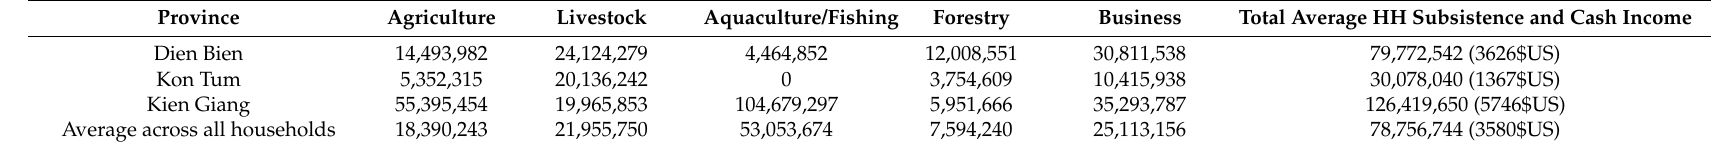
Table 2. Average household livelihood sources and values in VND.